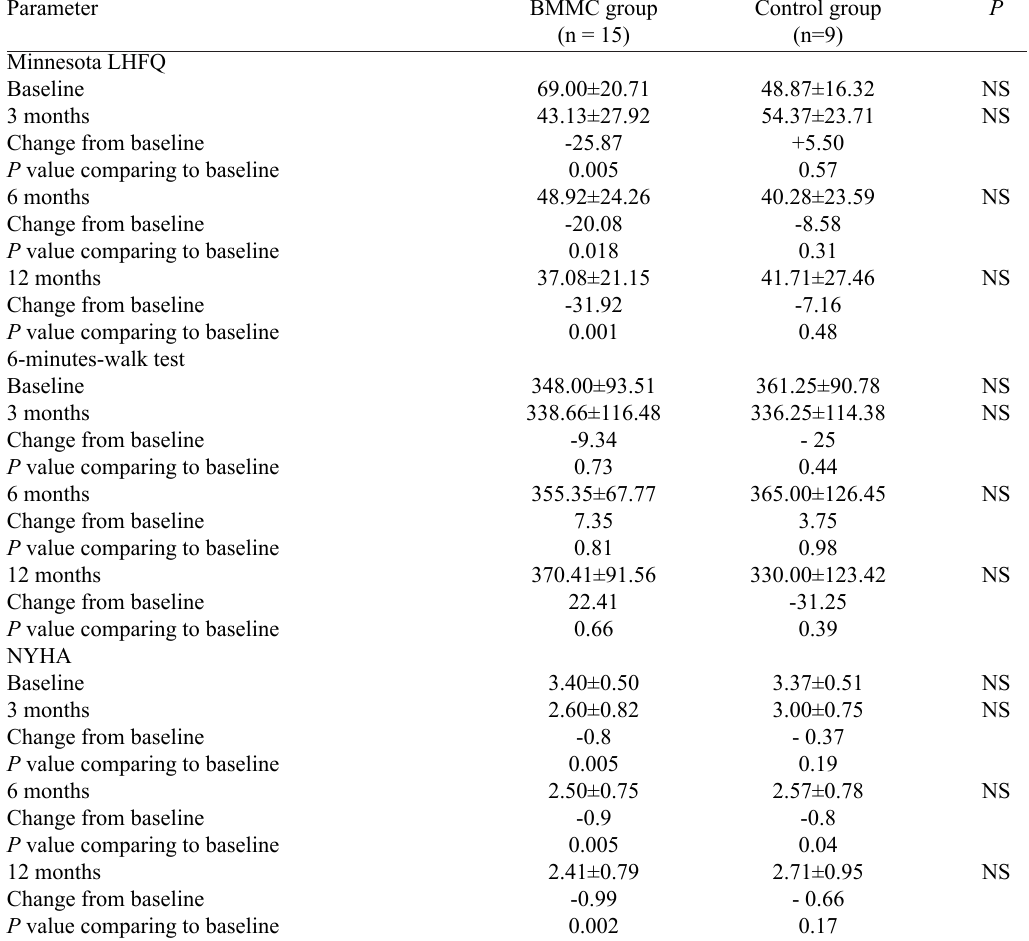
Table 5. Minnesota Living with Heart Failure Questionnaire, New York Heart Association Functional Class